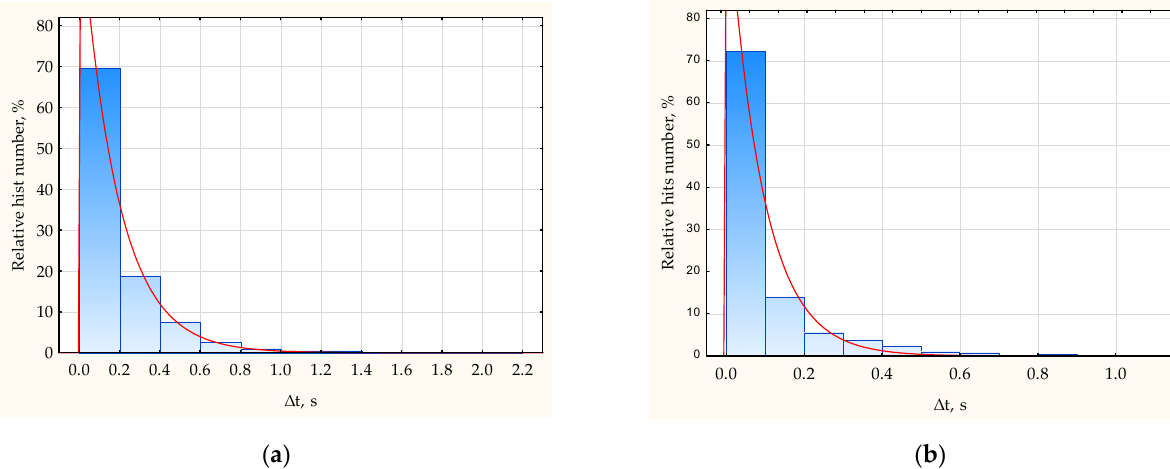
Figure 7. Distribution of time intervals between the adjacent AE hits. ( a ) For defect-free dissimilar weld specimen, and ( b ) for dissimilar weld specimen with lack of penetration.